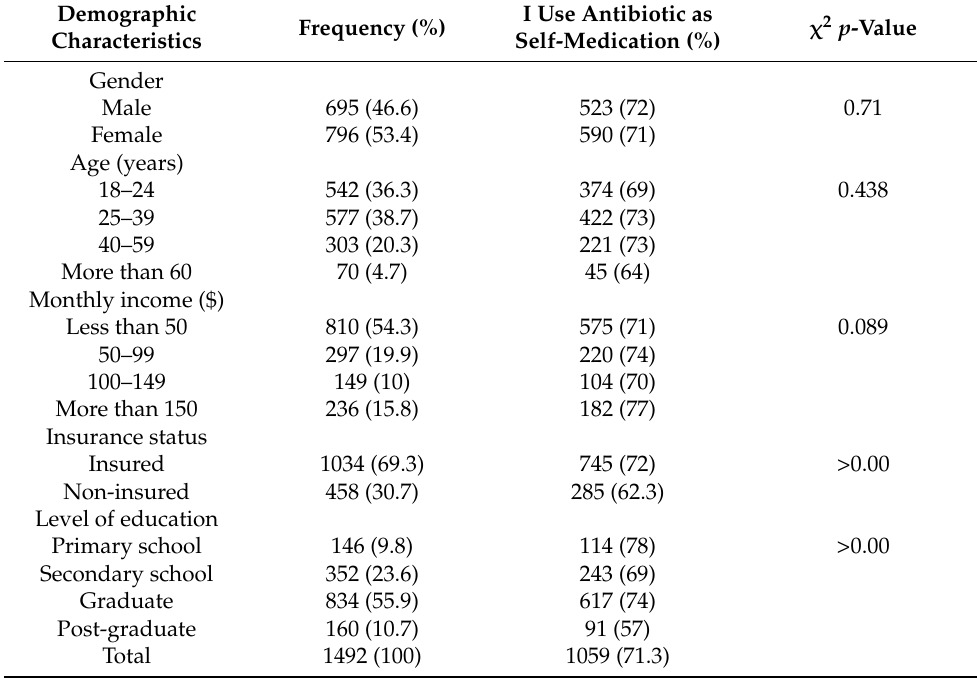
Table 1. Demographic characteristics of the included participants and their association with the use of antibiotic as self-medications.